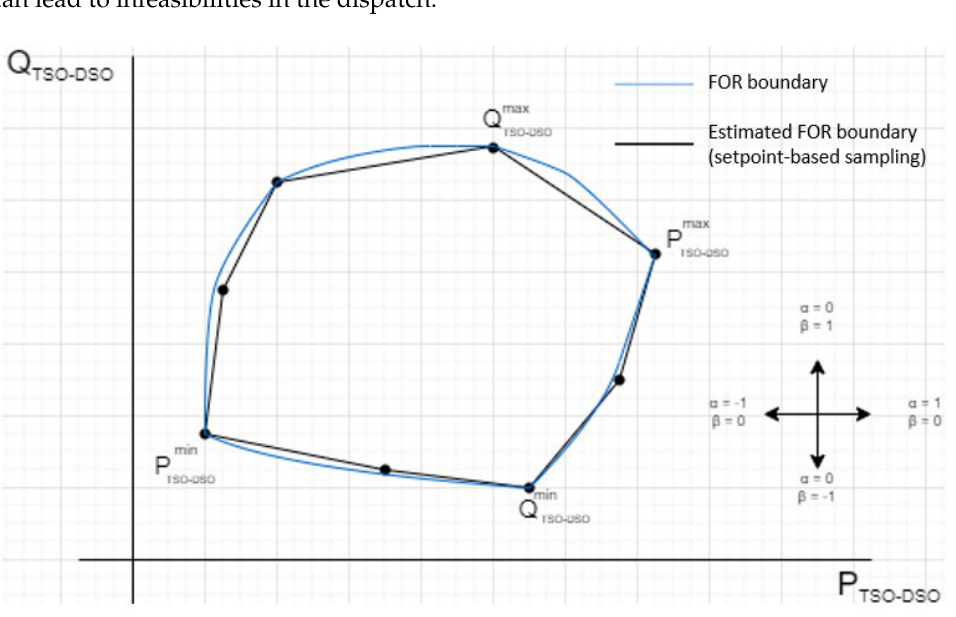
Figure 6. Visualization of setpoint-based sampling.